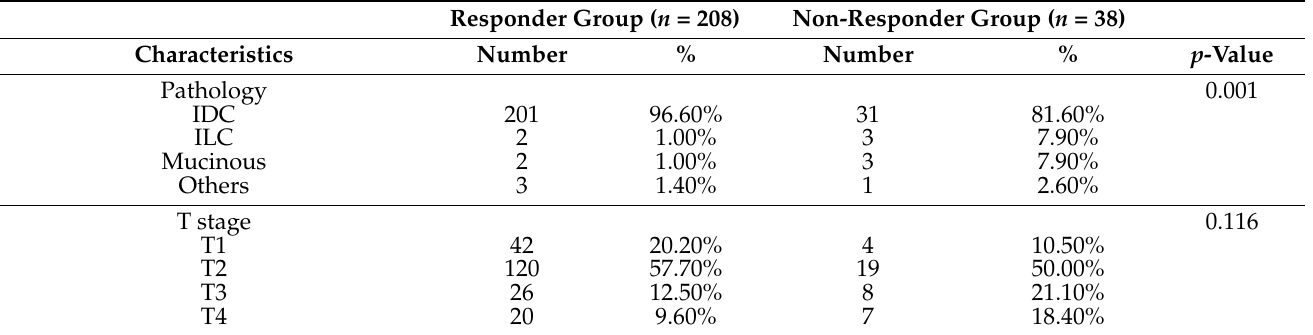
Table 4. Comparison of tumor characteristics according to the response to neoadjuvant